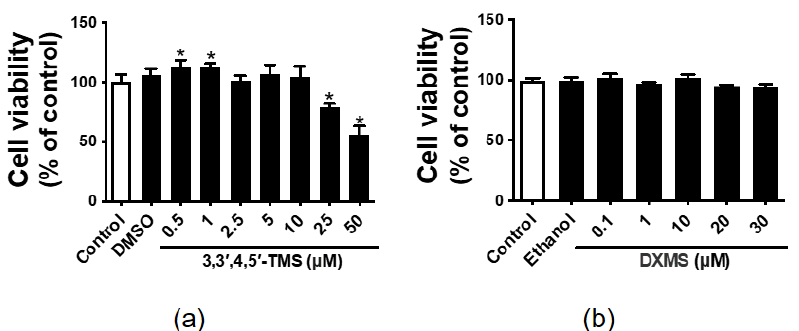
Figure 1. The effects of 3,3 (cid:48) ,4,5 (cid:48) -tetramethoxy-trans-stilbene (3,3 (cid:48) ,4,5 (cid:48) -TMS) and dexamethasone (DXMS) on cell viability in the HepG2 cells. The cell viability after treated with different concentra- tions of ( a ) 3,3 (cid:48) ,4,5 (cid:48) -TMS and ( b ) DXMS in the HepG2 cells for 48 h. Values are the means ± SEM ( n = 3); * p < 0.05 vs.